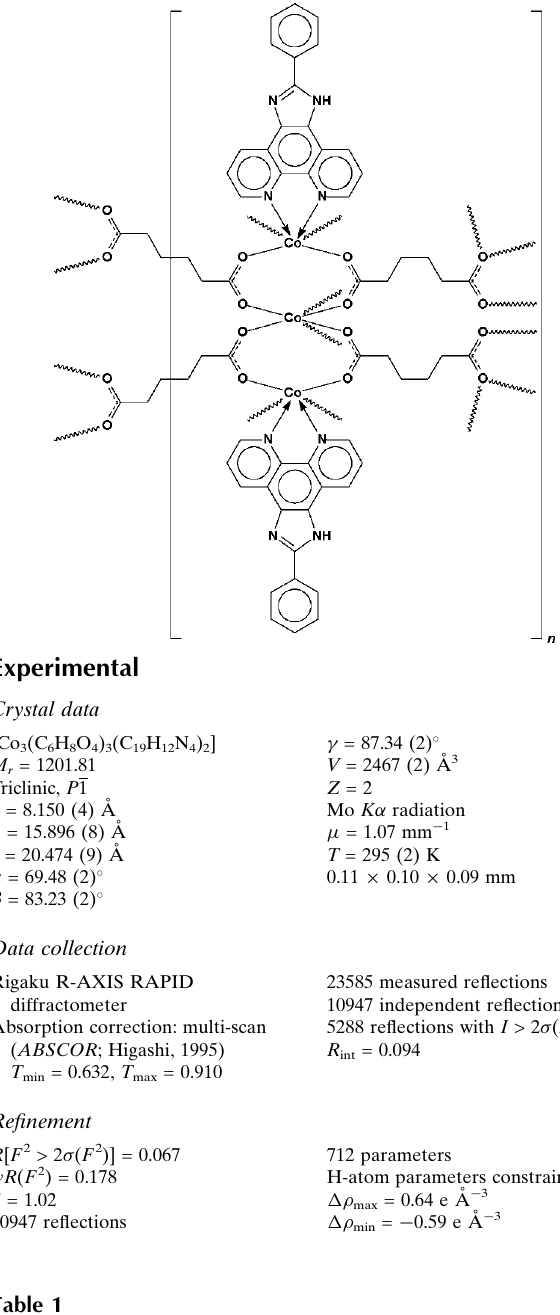
Selected bond lengths (A˚